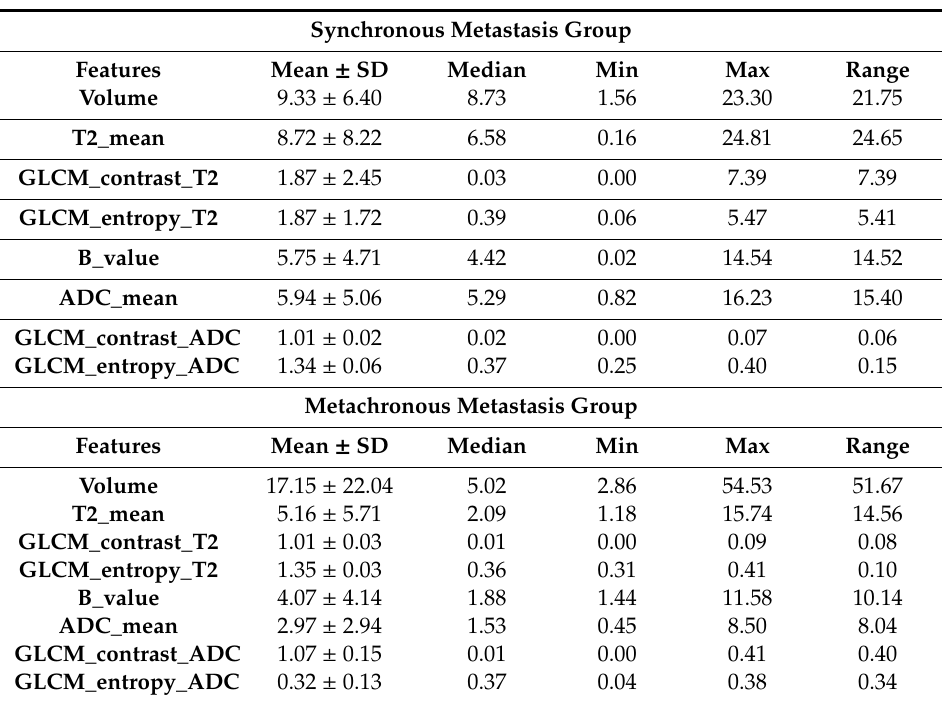
Table 3. Descriptive statistics of features extracted from MRI